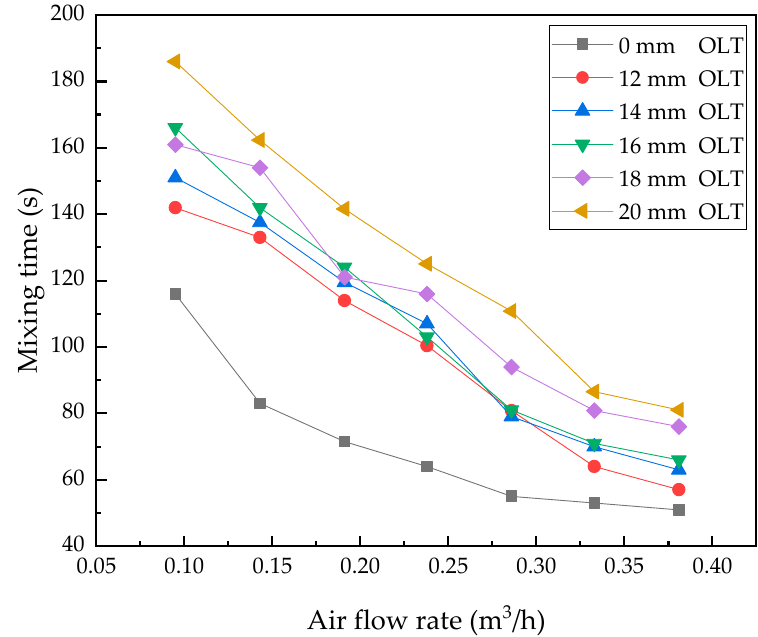
Figure 4. The relation of mixing time and air flow rate in the ladle with double porous plugs.